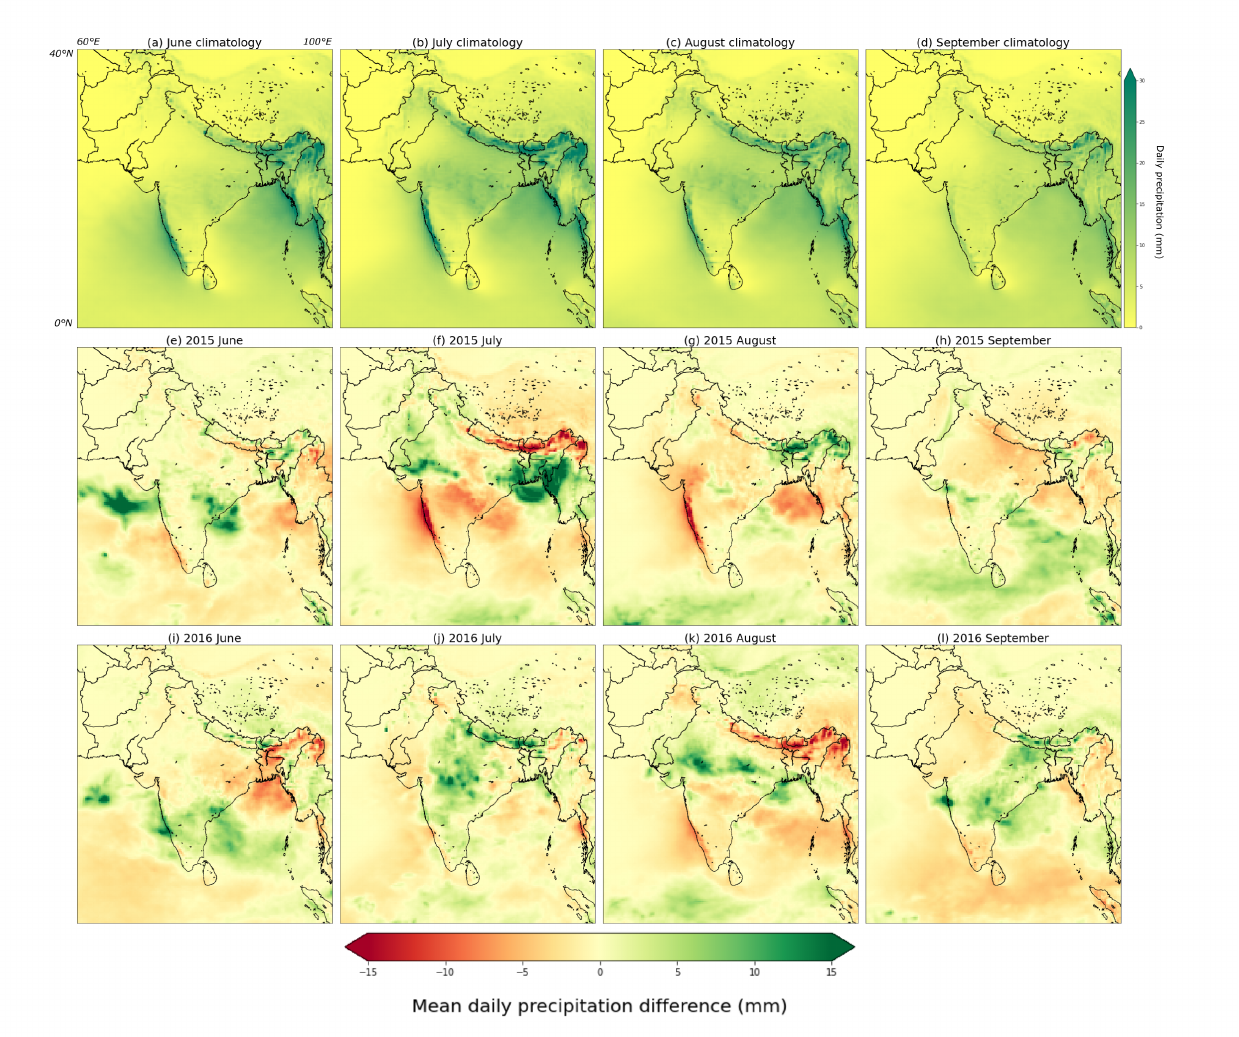
Figure 5. Precipitation (mm/day) during the monsoon season over the whole ISM region. Panels textbfa to textbfd show the climatology based on 1979 to 2018 JJAS data. Panels e to h and i to m show the mean monthly 2015 and 2016 difference of precipitation, respectively, calculated by subtracting the 2015 or 2016 monthly values from the 40-year climatology